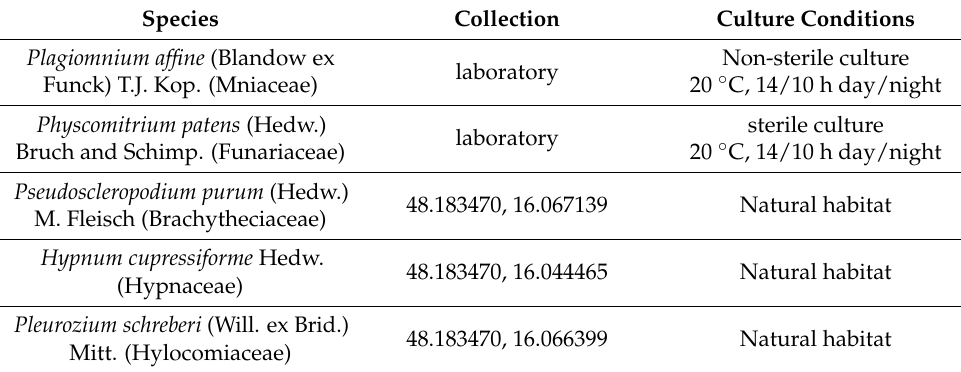
Table 4. Taxonomy, origin, and culture of the plant material. Species